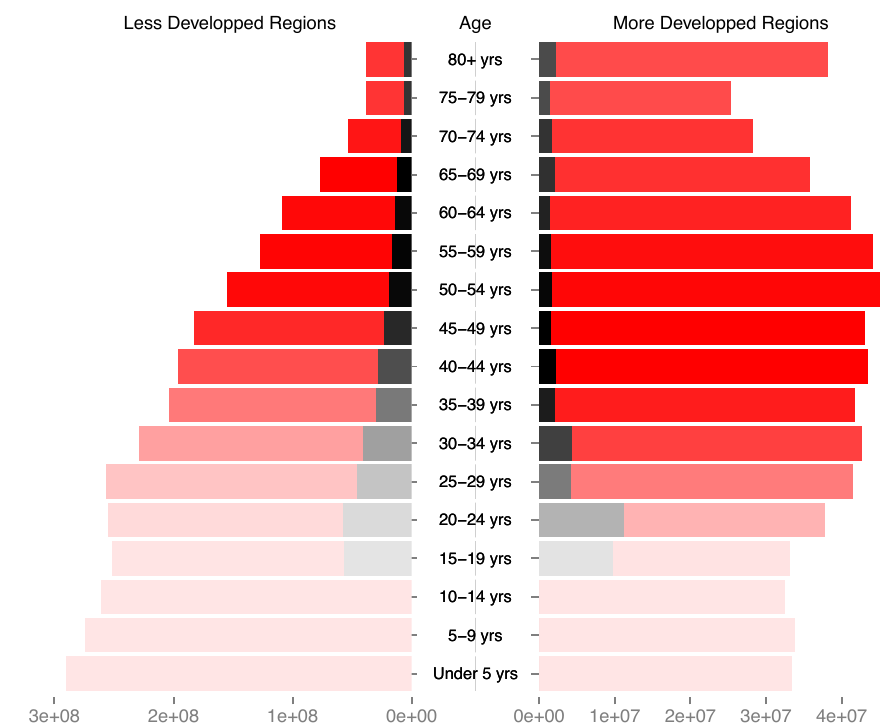
Figure 1. Number of women with asymptomatic cervical human papillomavirus (HPV) infections (black bars) as a function of age class (red bars) and of country development status. Bar color intensity reflects the prevalence of cervical cancer in the corresponding age class (and hence the focus of current research). Data should be read as follows, using the 30–34 years of age as an example: in less developed regions, among the 228 million women in the age class, 40 million (17.8%) display a normal cytology but are actually infected by HPVs, and 30 thousand (0.013%) suffer from cervical cancer, while in more developed regions among the 42 million women in the age class, 4.3 million (10.2%) display a normal cytology but are actually infected by HPVs, and six thousand (0.015%) suffer from cervical cancer. Data correspond to HPV prevalence in women with normal cytology, as estimated by the HPV information center (http://hpvcentre.net/, [4]). Overall HPV prevalence values will actually be larger, as they will include women with abnormal cytology. No data were available for HPV prevalence in women below 15 years of age. Demographic data correspond to the UN projections for 2015 (note the different scales between the less and more developed